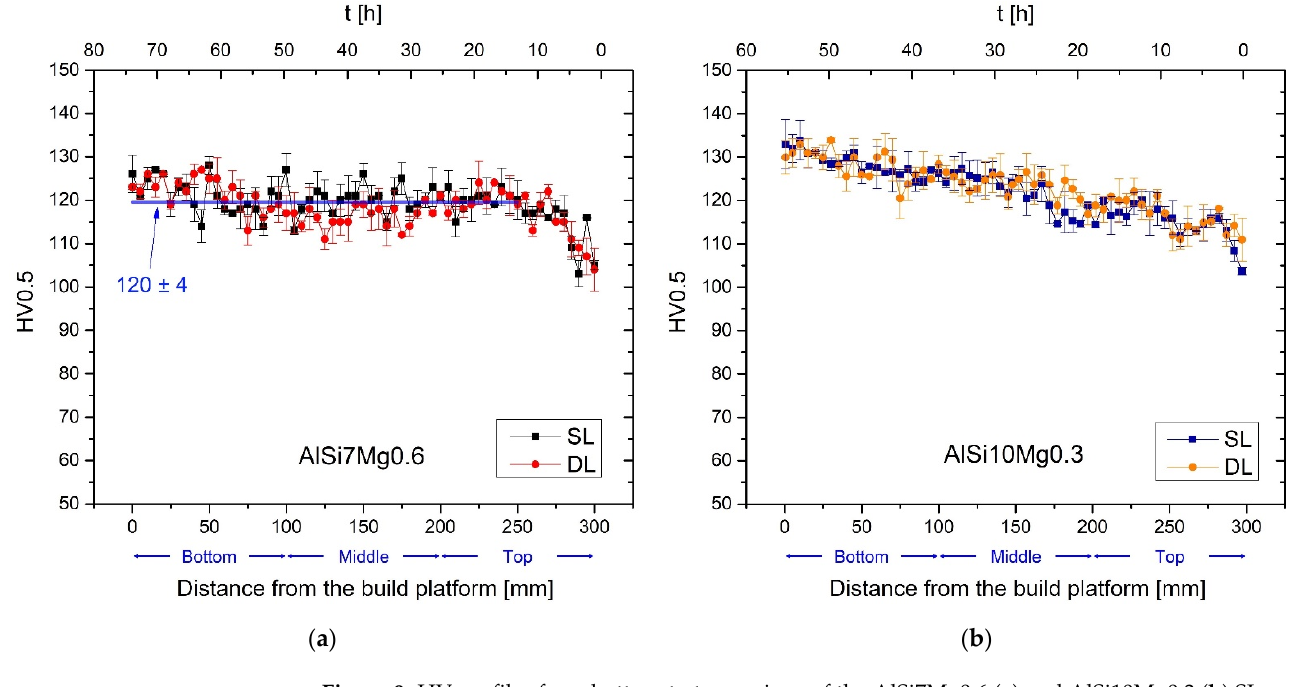
Figure 9. HV profiles from bottom to top regions of the AlSi7Mg0.6 ( a ) and AlSi10Mg0.3 ( b ) SL and DL bars. Table 5. Vickers microhardness values, and their variation, measured on the as ‐ built and direct aged AlSi7Mg0.6 and AlSi10Mg0.3 samples. For each DA at 175, 200 and 225 °C, the HV measured at the peak ‐ aging and after 16 h of treatment were listed.